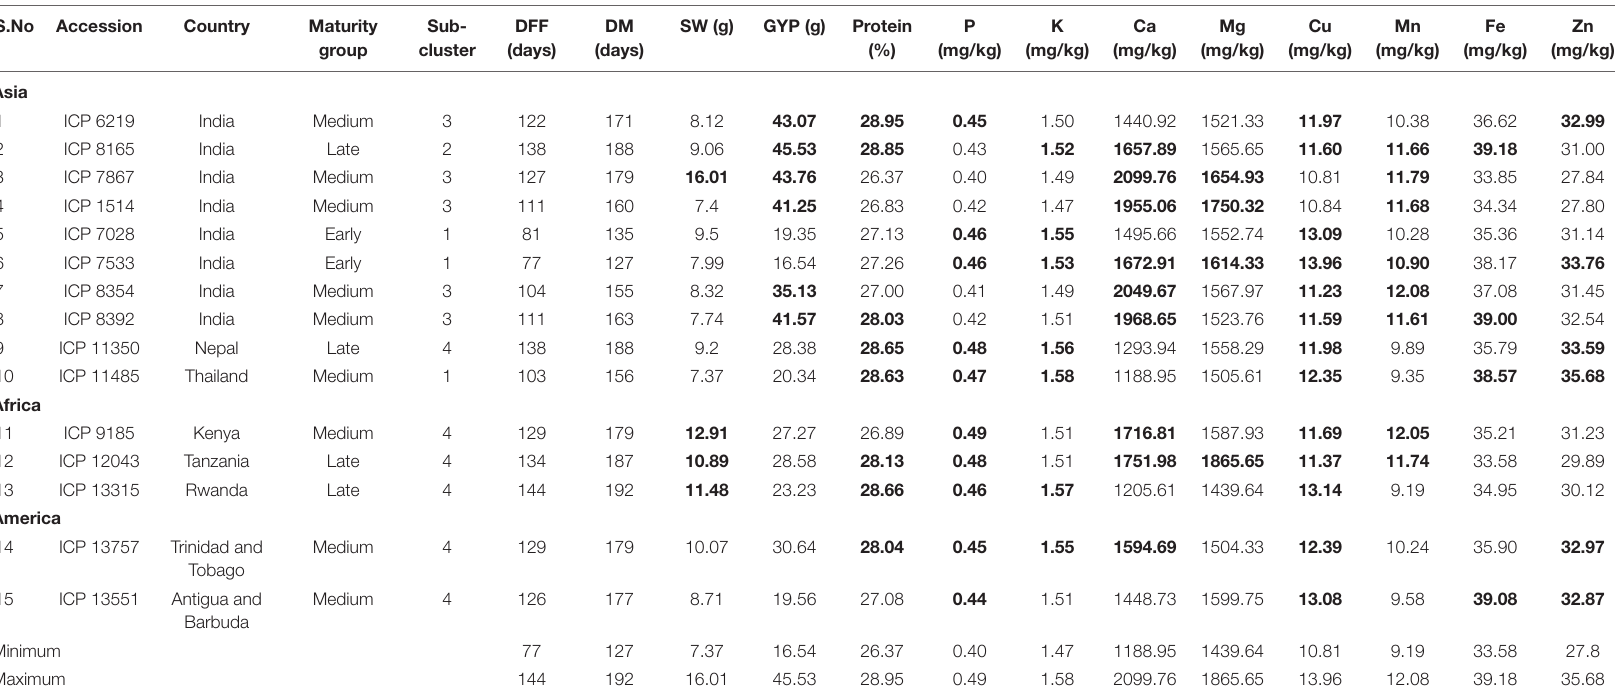
TABLE 4 | Promising multi-nutrient dense pigeonpea landraces identified from 598 pigeonpea accessions evaluated during the 2019 and 2020 rainy seasons at ICRISAT, India. S.No